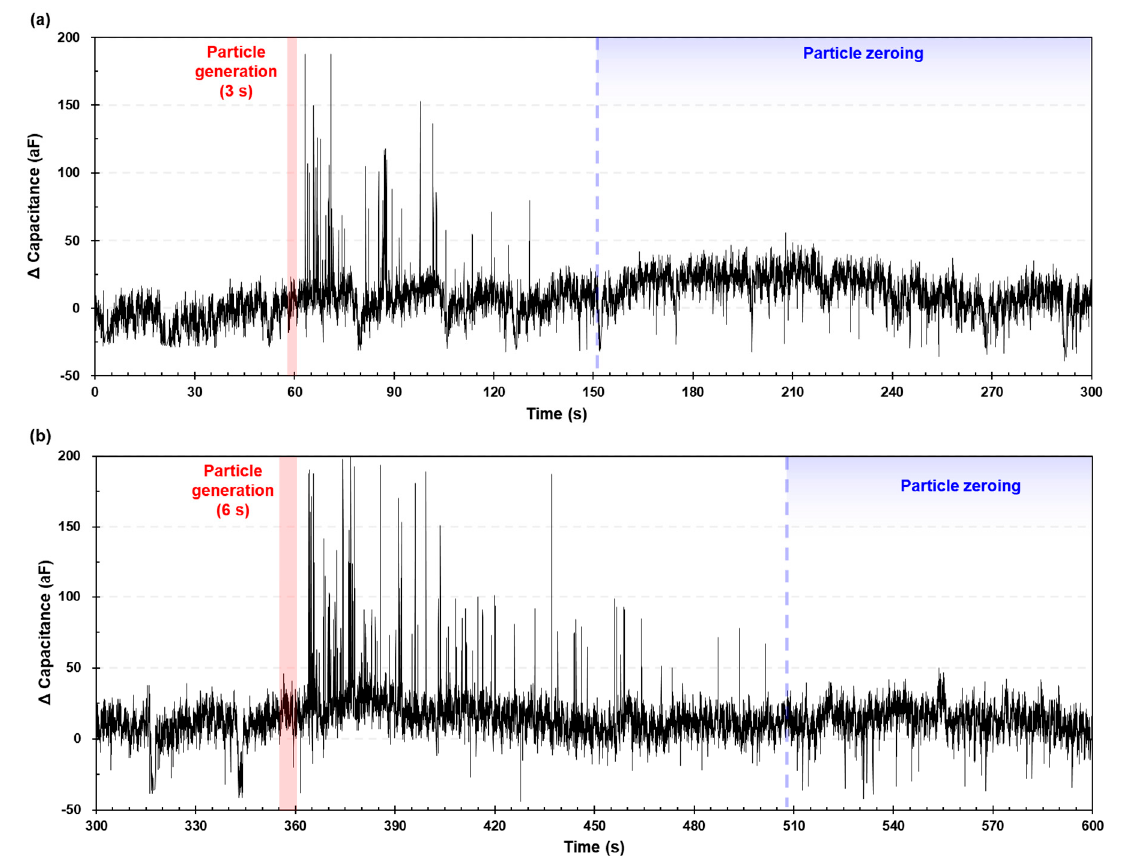
Figure 15. Performance evaluation of the proposed system in a test-bed condition; ( a ) 3 s and ( b ) 6 s.